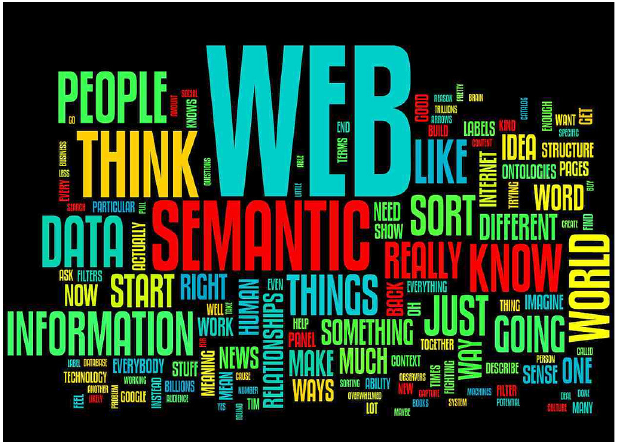
Figure 4 . PLENK2010 Wordle.